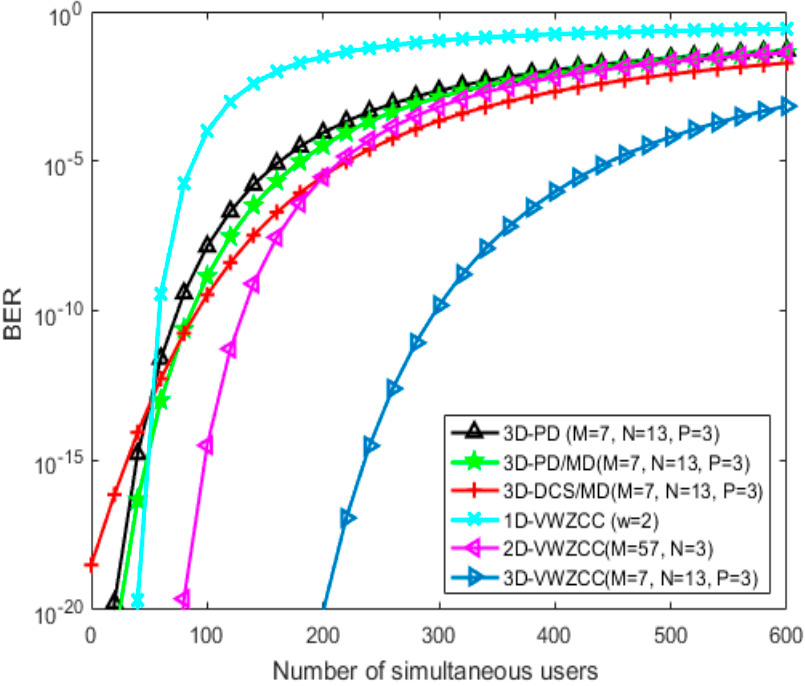
Figure 3. BER against number of simultaneous users when the effective power P sr = − 10 dBm and data rate R b = 1.25